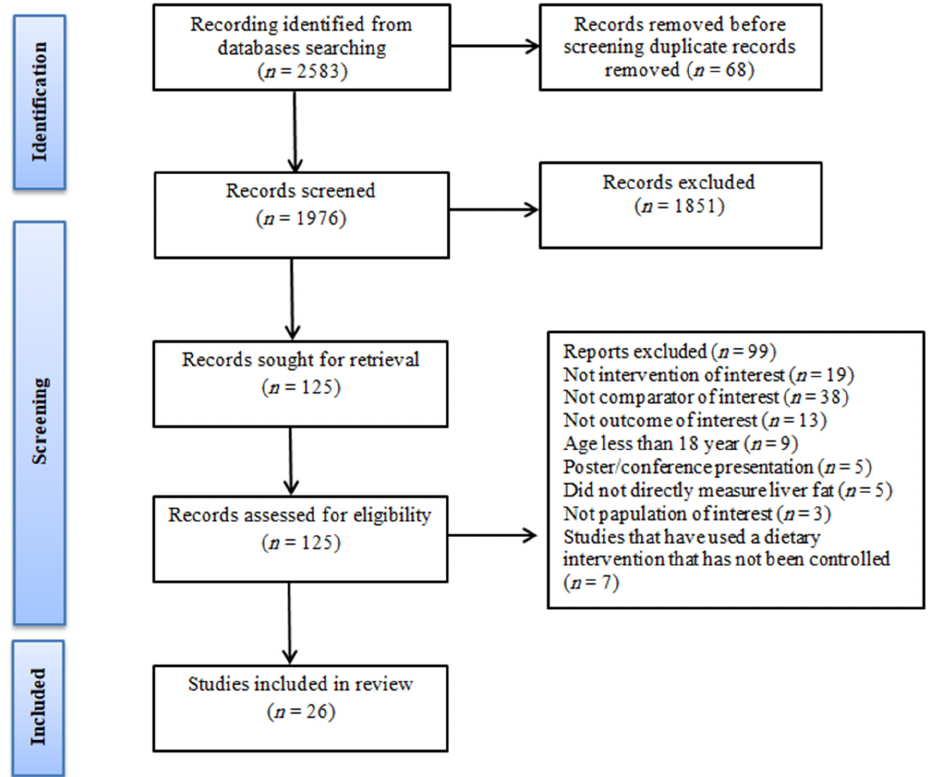
Figure 1. PRISMA flow diagram of the literature search.